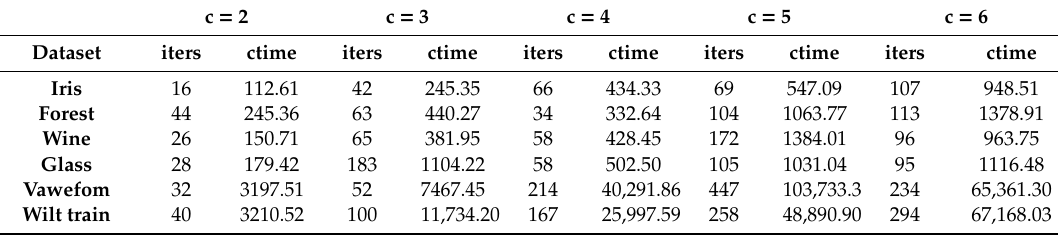
Table 8. Performance of the Irand algorithm on the real